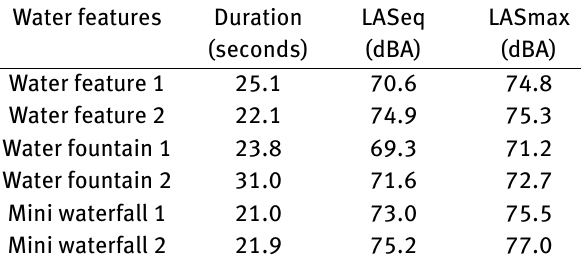
Table 1: The sound pressure levels in dBA for various water